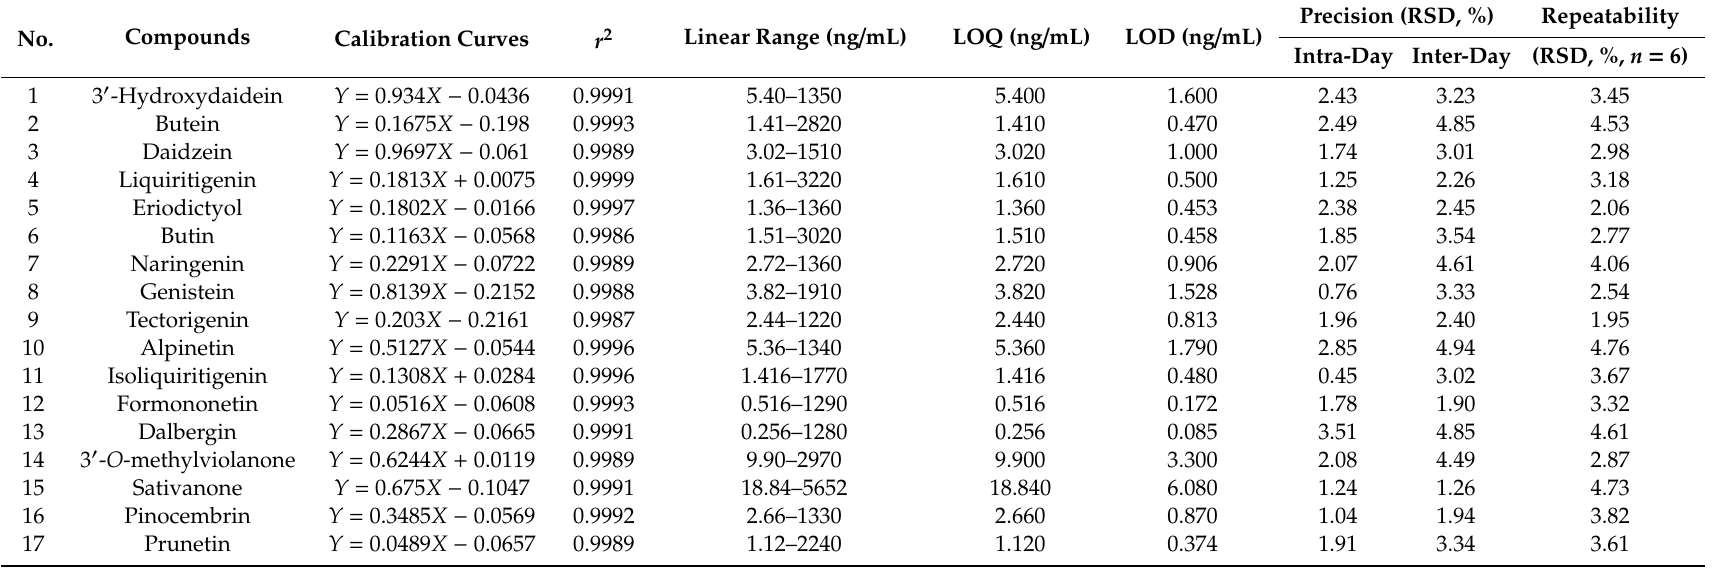
Table 2. Curves, test range, limit of detection (LOD), limit of quantification (LOQ), precision, and repeatability for the seventeen